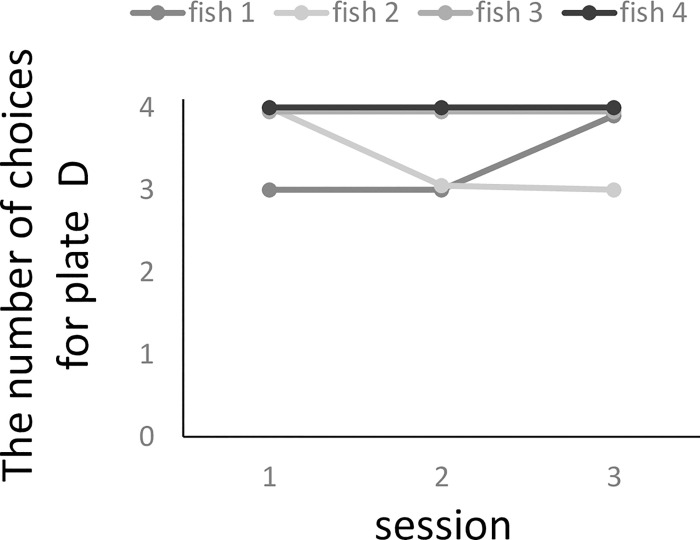
The number of choices of plate D in the BD test across BD test sessions.Each session consists of four trials.